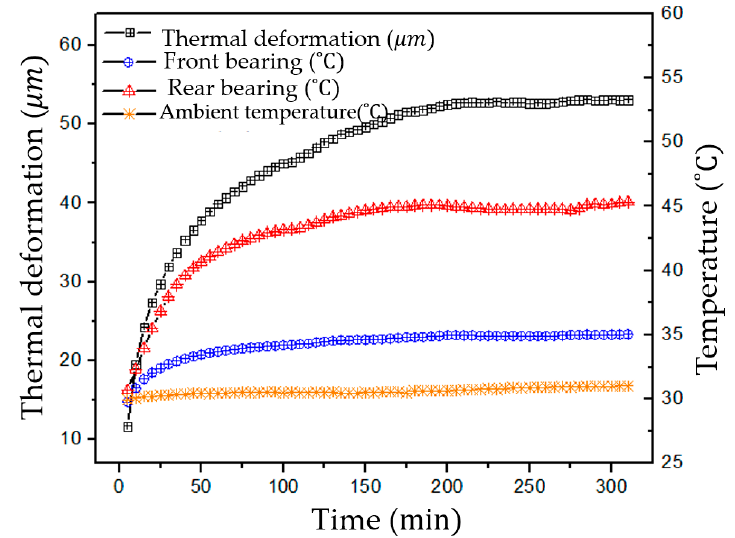
Figure 14. Experimental results of cooling of the original cooling channel design.